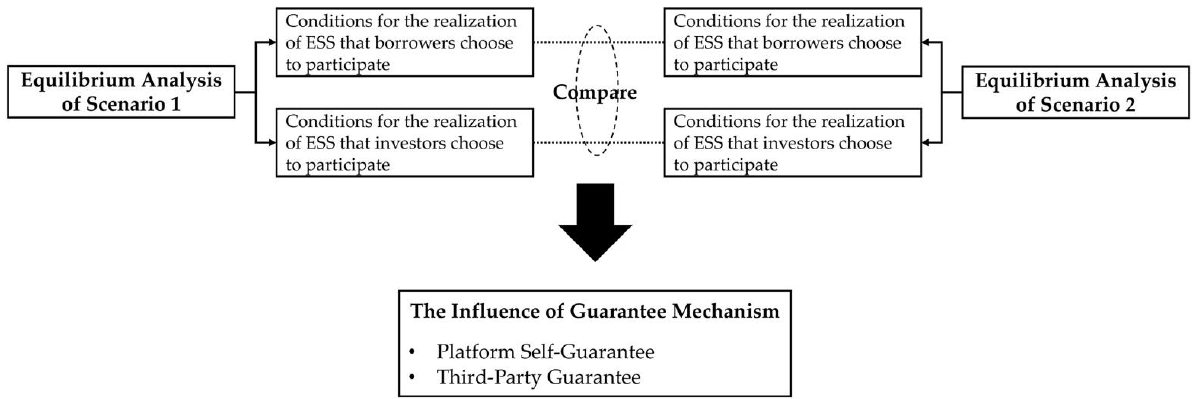
Figure 4. The block diagram of the evolutionary game